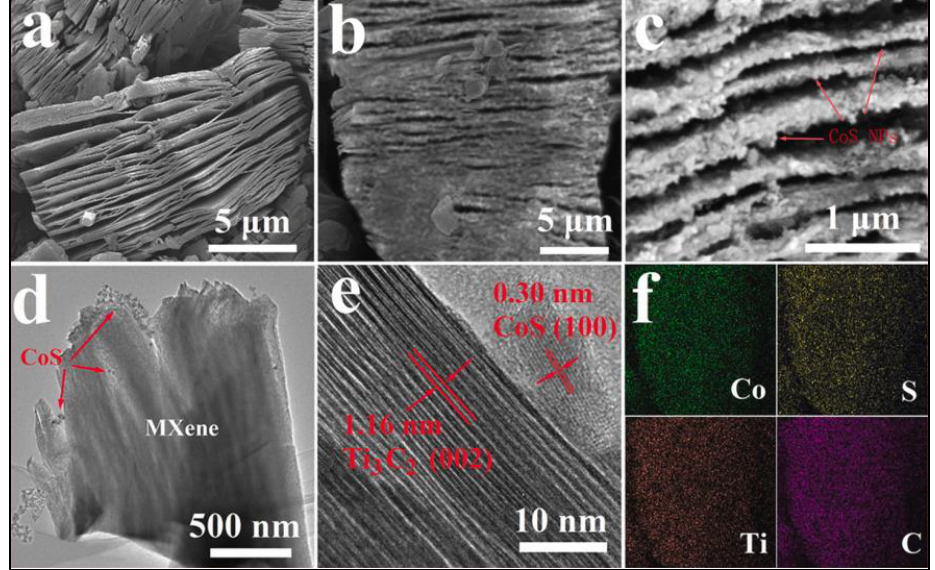
Figure 5. SEM images of ( a ) MXene and ( b , c ) MXene-CoS, TEM images of ( d , e ) MXene-CoS, and ( f ) an elemental mapping of MXene-CoS. The images have been reproduced with permission [111].